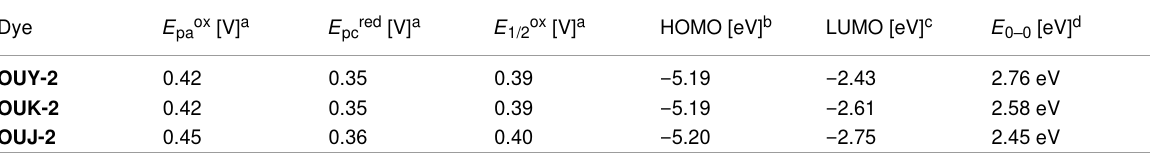
Table 2: Electrochemical data and HOMO and LUMO energy level of OUY-2, OUK-2 and OUJ-2 . Dye OUY-2 OUK-2